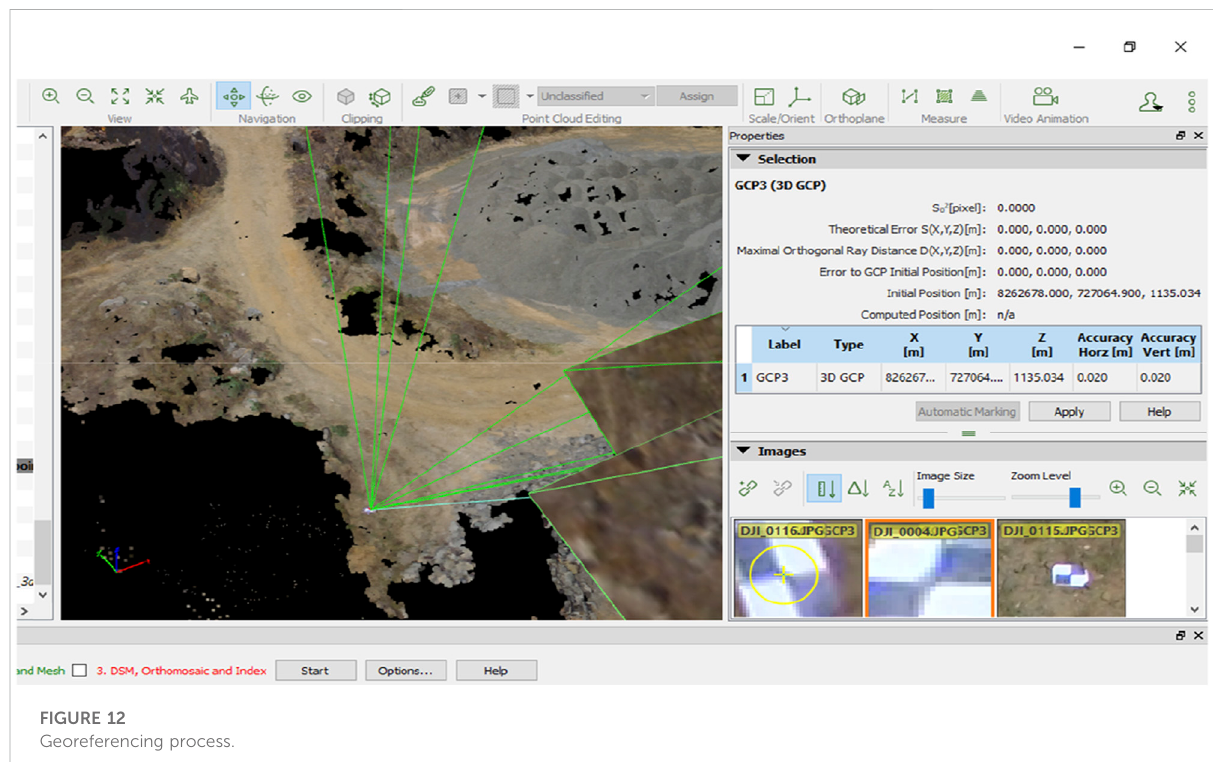
FIGURE 12 Georeferencing